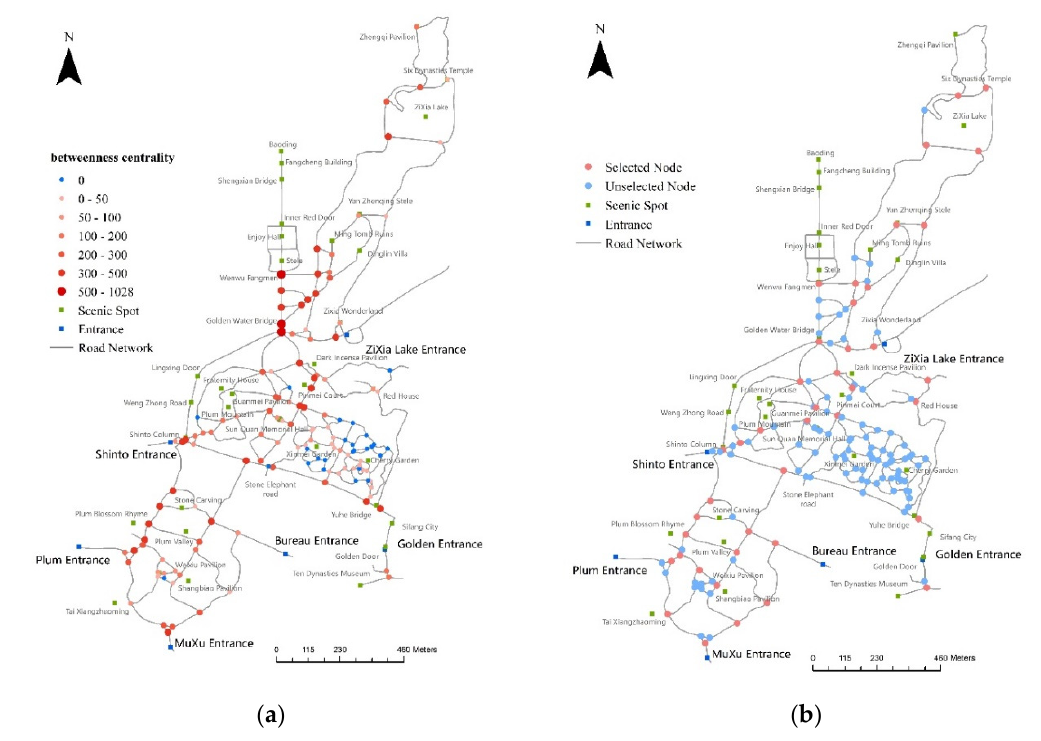
Figure 7. The generated result in the experimental area. ( a ) The betweenness centrality of each extracted junction nodes with a red circle in a different size; ( b ) the selected junction nodes for directional sign placement with a blue circle.